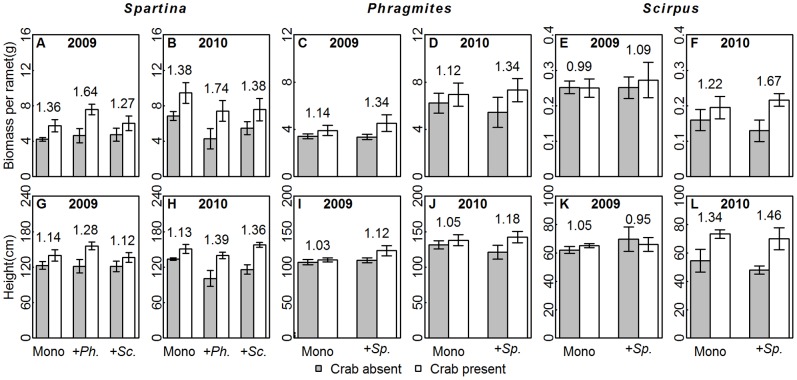
The plant performance at ramet-level.The biomass per ramet (mean±SE, A–F) and height (mean ± SE, G–L) of three species with/without crab disturbance in five species combinations are presented. The categories on X axis present different species combinations. “Mono”, “+Sp.”, “+Ph.” and “+Sc.” are abbreviations for “monocultures”, “with Spartina”, “with Phragmites” and “with Scirpus”, respectively. The Rcrabs of three species in specific species combinations were given above the bars.